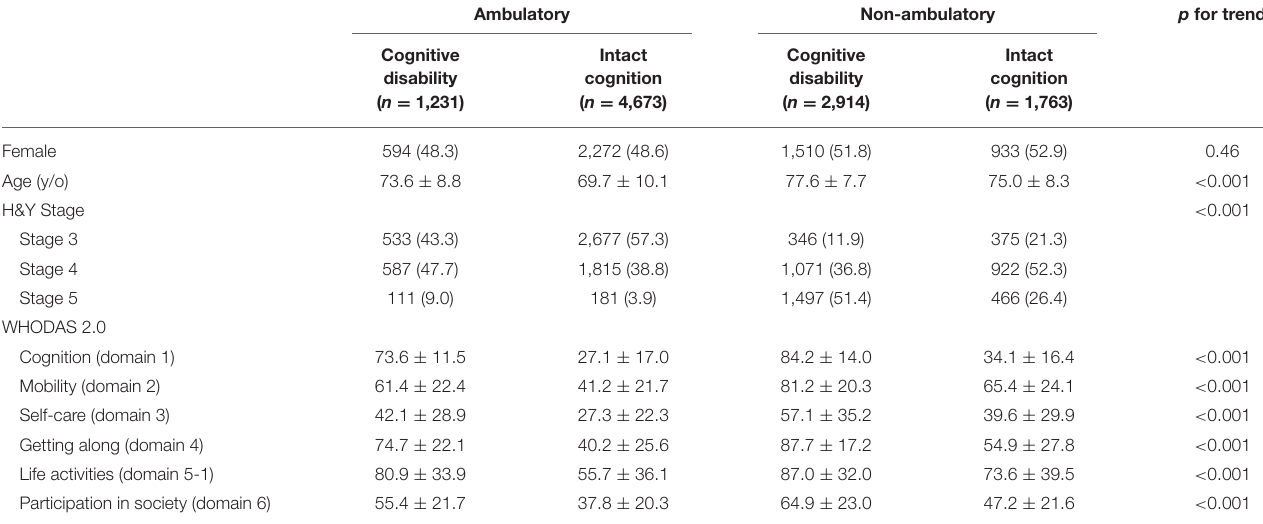
TABLE 2 | Subgrouping of all study participants based on ambulation and cognition, n = 10,581.